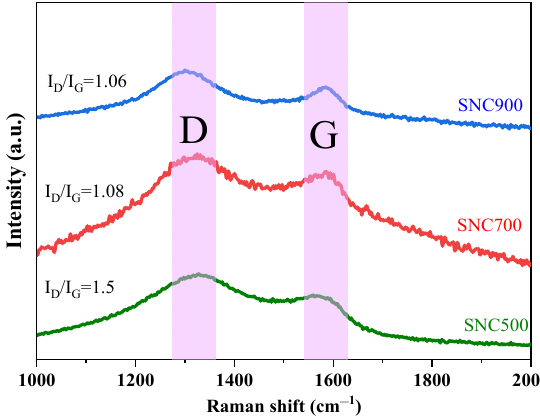
Figure 6. Raman spectra of SNC at different carbonization temperatures.